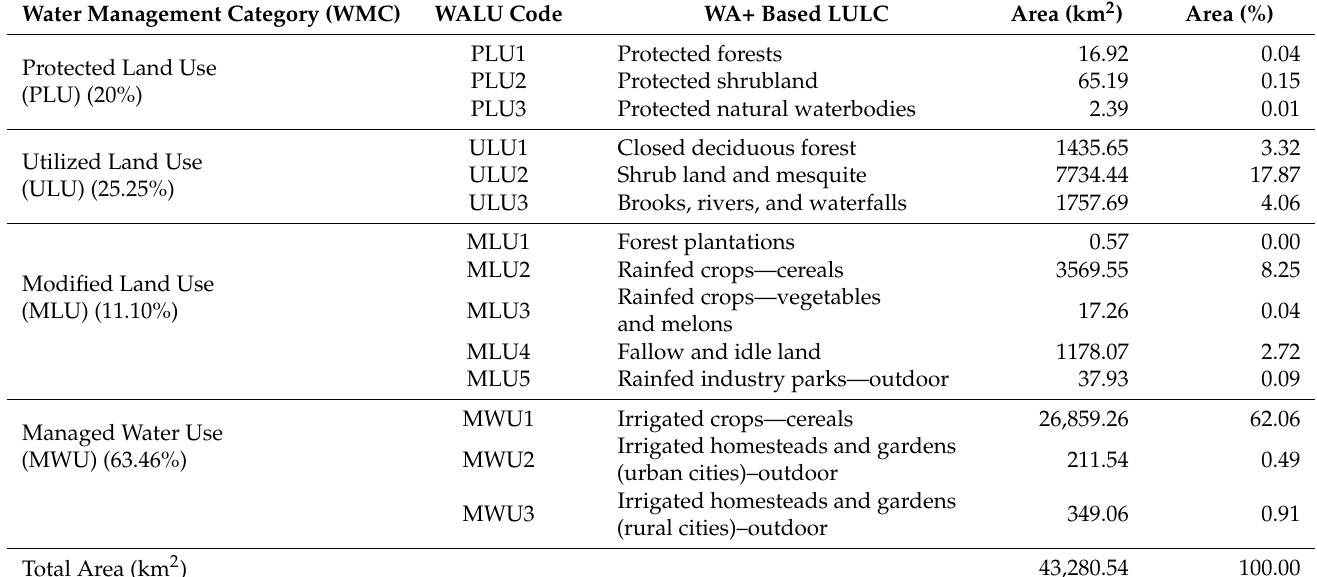
Table 3. The area wise distribution of WALU-based land use classes in the study